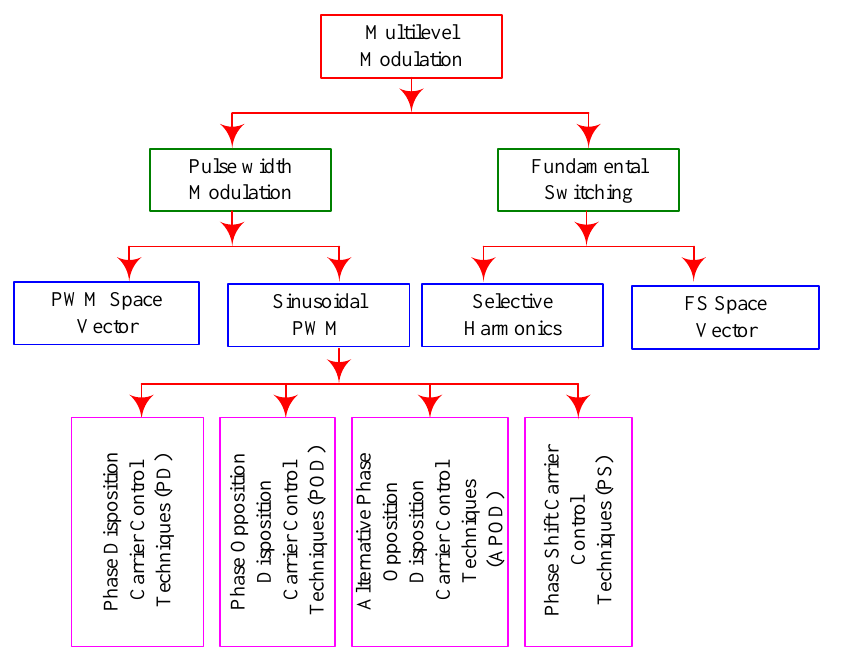
Figure 1. Classification of modulation strategies.